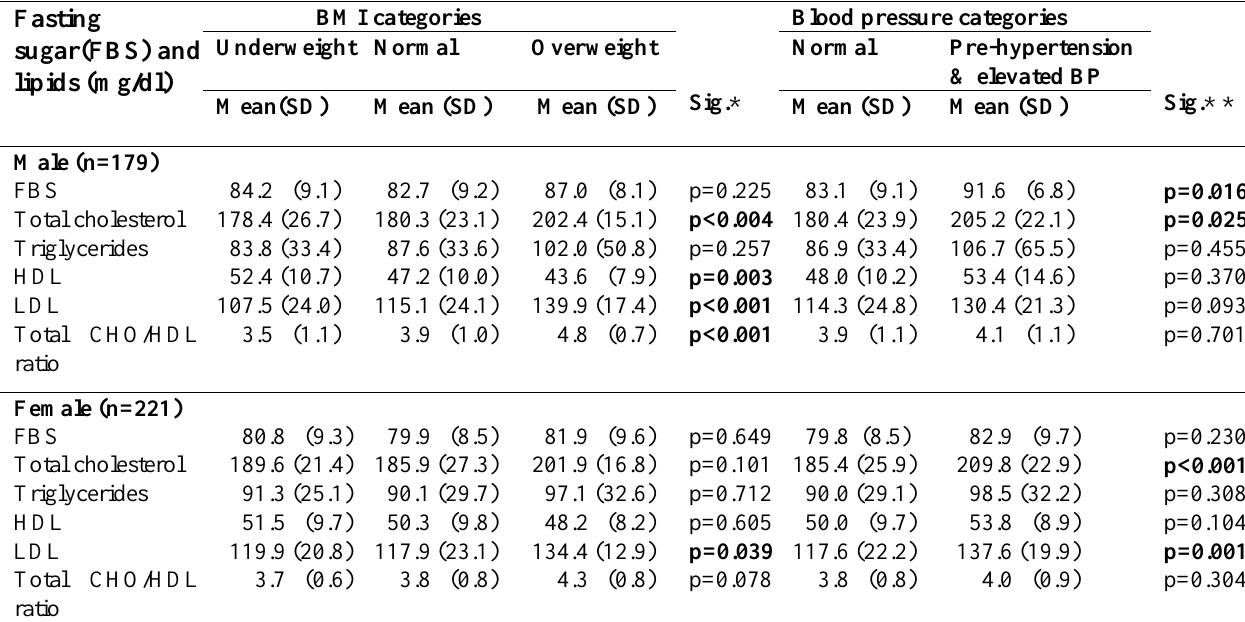
Table 4. Mean fasting blood sugar and lipid levels of male and female students according to the BMI category and blood pressure levels